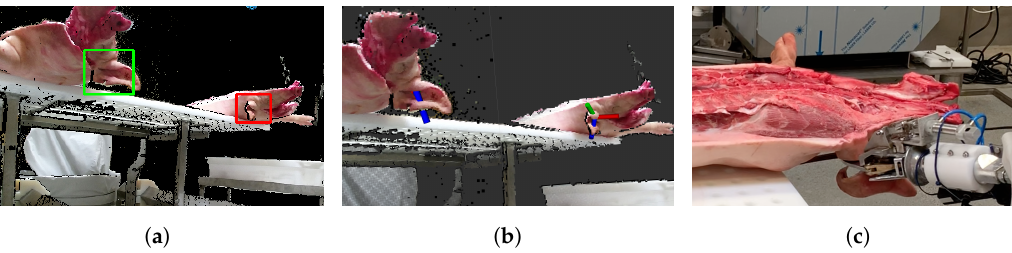
Figure 15. Test highlights. ( a ) Localization of ears. ( b ) Pose prediction. ( c ) During execution of the cut.